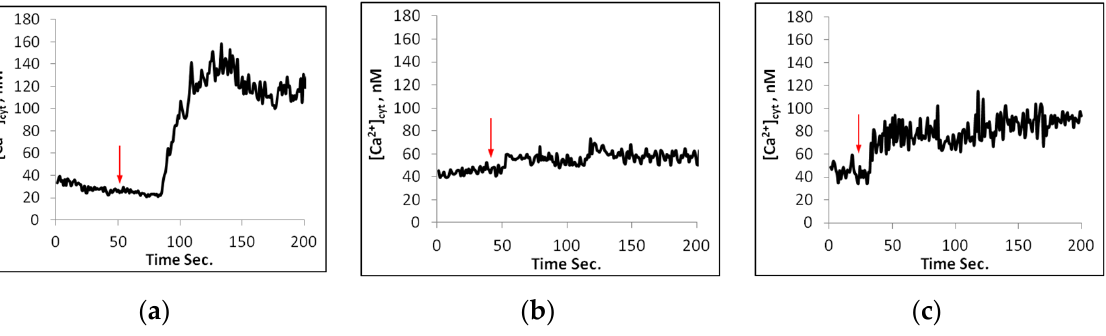
Figure 3. Changes of [Ca 2+ cyt ] in nM with time, upon addition of 100 mM of NaCl to single mesophyll protoplasts of Arabidopsis wild type ( a ), sos1 ‐ 1 ( b ), and nhx1 ( c ). Measurements at excitation ratio 340/380 nm and emission 510–550 nm. Typical traces.